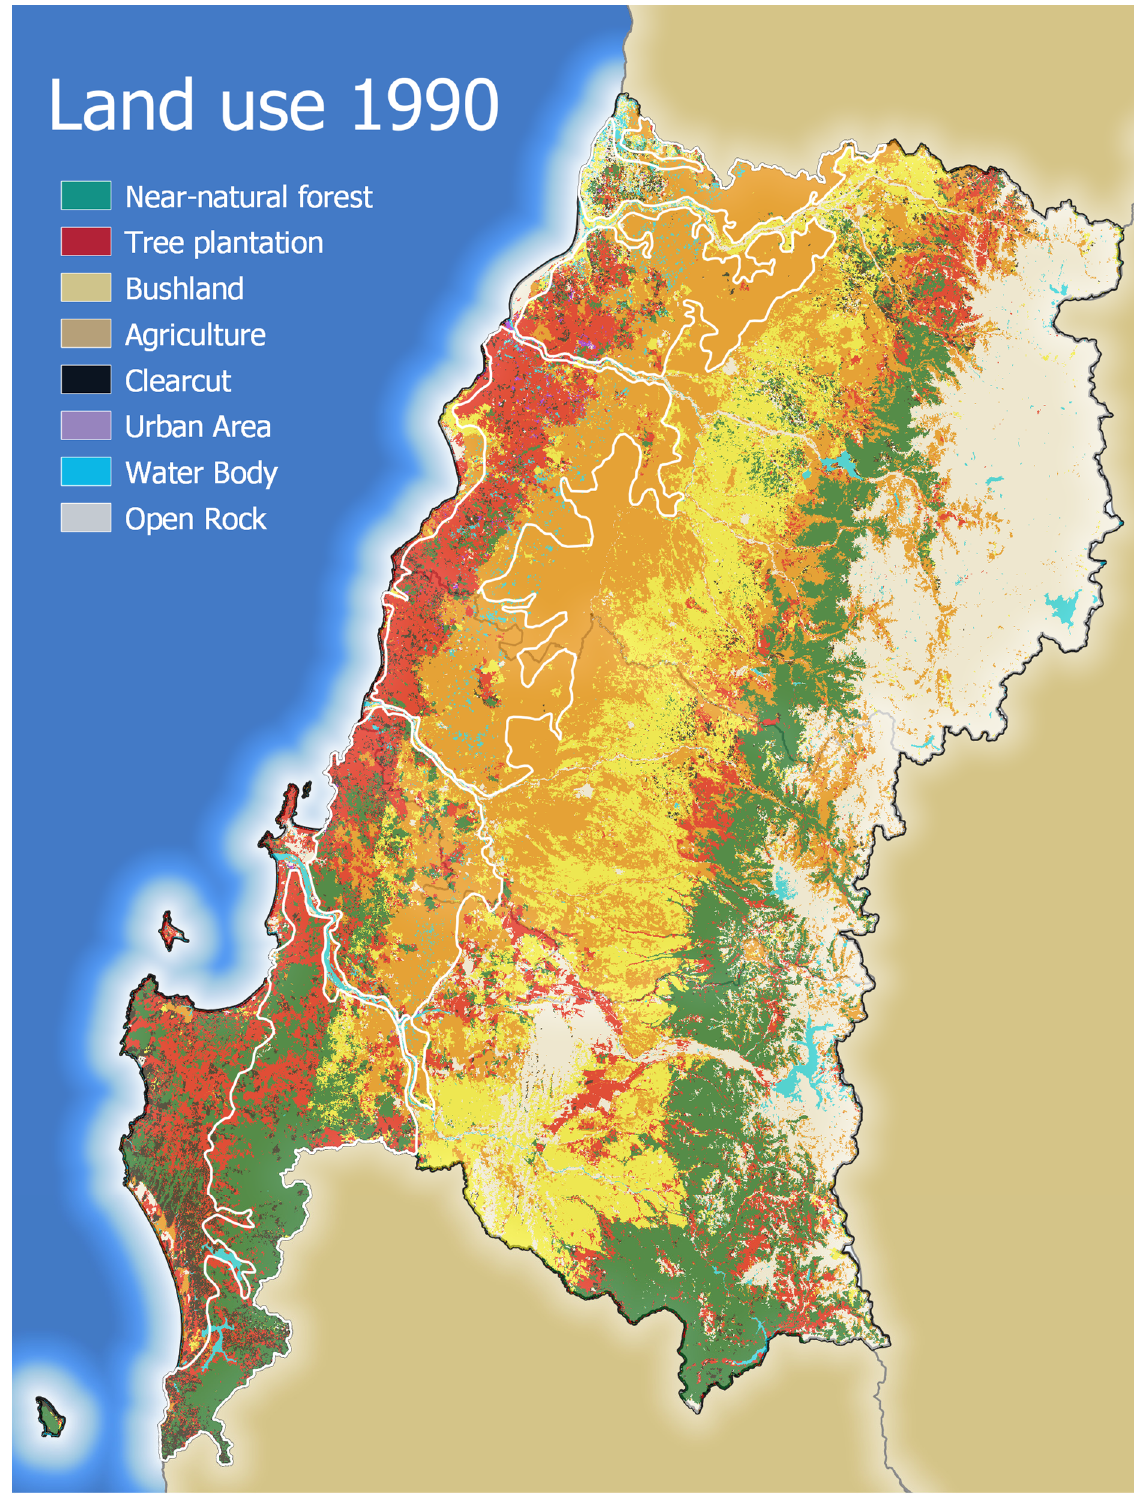
Figure A4. Land use map of study site in 1990.